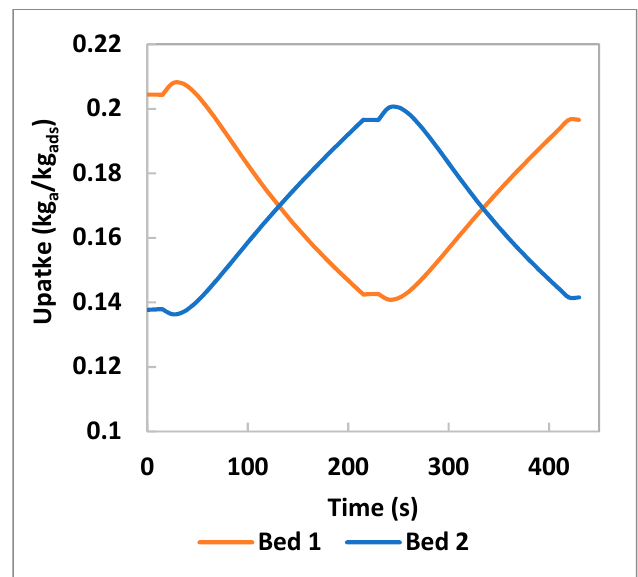
Figure 7. the average uptake of the two beds over a complete cycle .